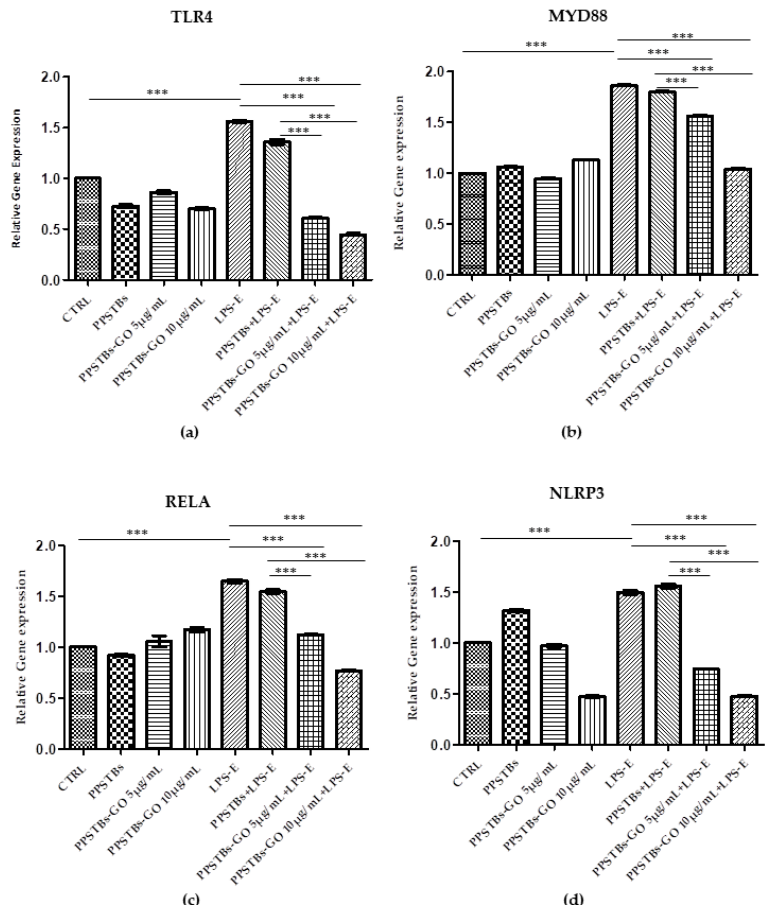
Figure 10. ( a – d ) Histograms of RT-PCR showed the mRNA levels of TLR4, MYD88, REALA, NLRP3 in untreated cells (CTRL), in hGFs cultured with PPSTBs, in hGFs cultured with PPSTBs enriched with GO at 5 µ g/mL, in hGFs cultured with PPSTBs enriched with GO at 10 µ g/mL, in hGFs stimulated with LPS-E, in hGFs cultured with PPSTBs and stimulated with LPS-E, in hGFs cultured with PPSTBs enriched with GO at 5 µ g/mL and stimulated with LPS-E and in hGFs cultured with PPSTBs enriched with GO at 10 μ g/mL and stimulated with LPS ‐ E. *** p < 0.001 .